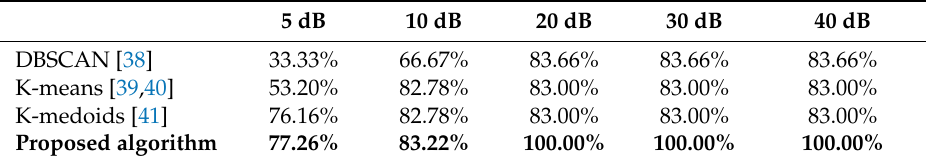
Table 3. The classification accuracy of original algorithms and proposed algorithm with different SNRs. 5